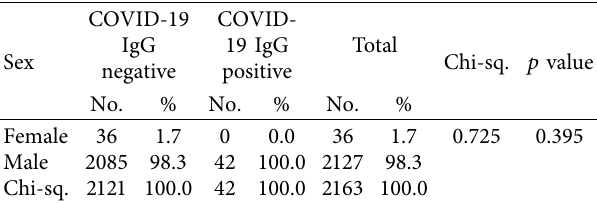
Table 2: COVID-19 IgG positive status among blood donors according to gender.